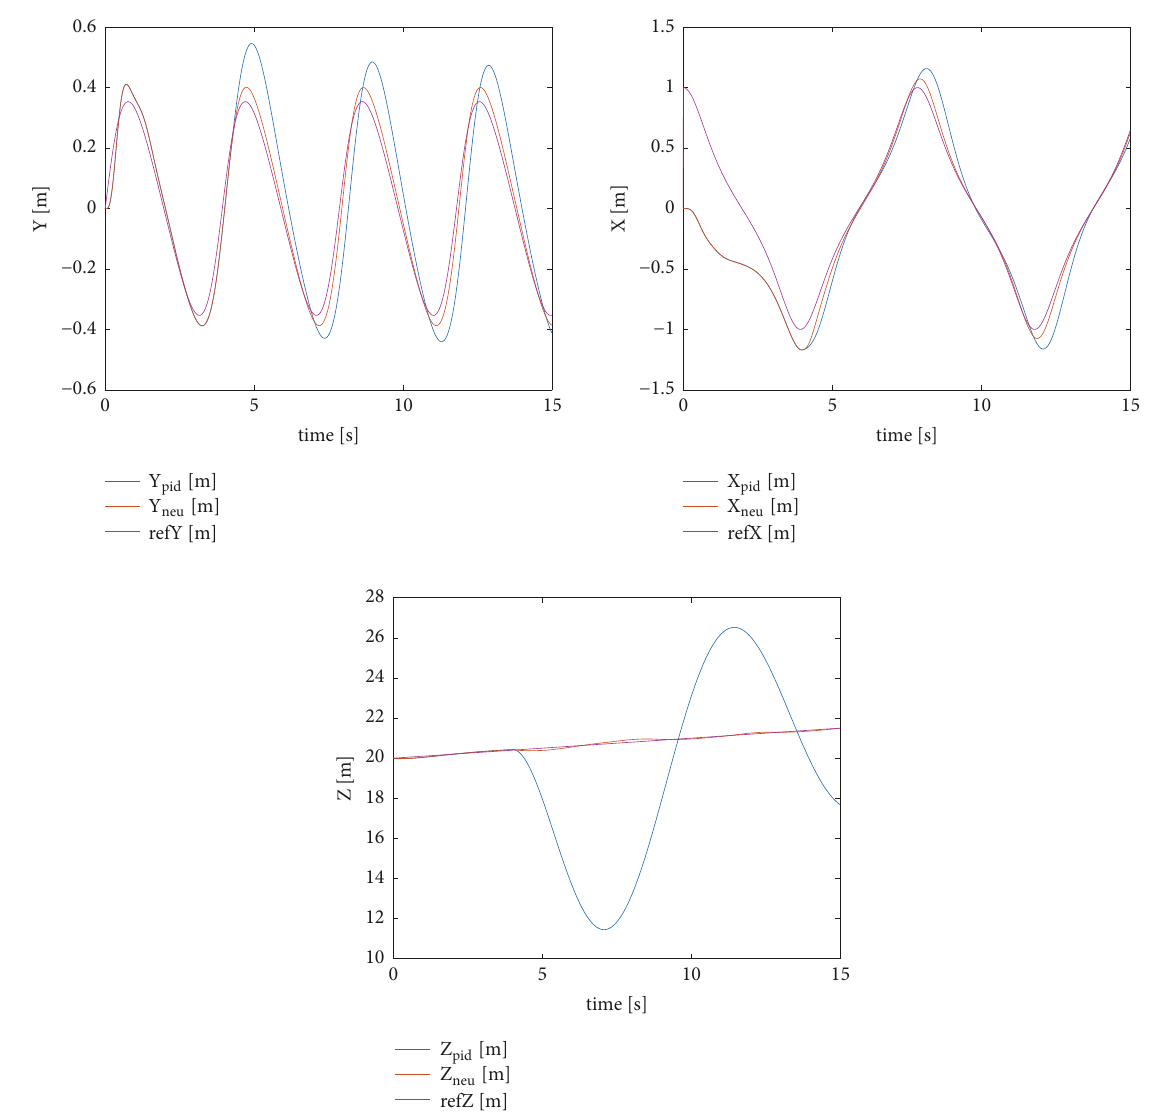
Figure 13: UAV tracking trajectory of X, Y, and Z coordinates, respectively, with mass